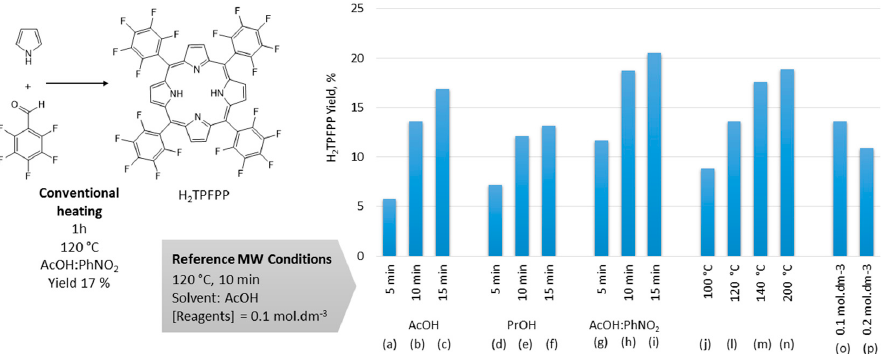
Figure 2. Synthesis of H 2 TPFPP in conventional heating conditions and screening of the microwave (MW) reaction conditions. The reference conditions were used and ( a – c ) 5, 10, 15 min reaction times; ( d – f ) propionic acid as solvent with 5, 10, 15 min as reaction times; ( g – i ) acetic acid:nitrobenzene mixture as solvent with 5, 10, 15 min as reaction times; ( j – n ) different reaction temperatures; ( o – p ) different concentrations of reagents. The yields were determined by UV-Vis spectroscopy.